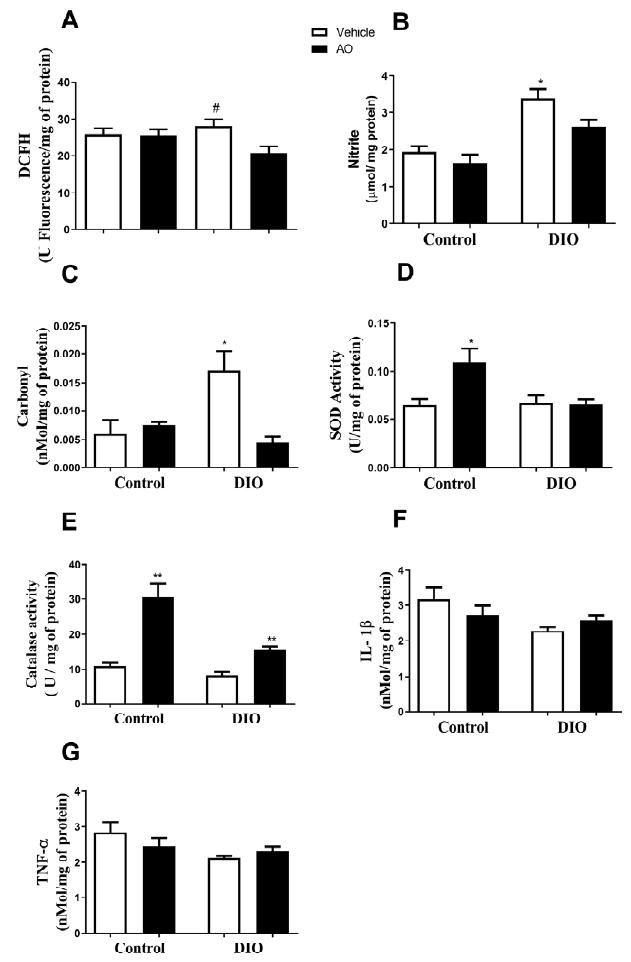
Figure 6. Effects of avocado oil (AO) supplementation on reactive species production, oxidative damage, antioxidant enzymes activity and cytokines levels in the liver of mice with diet-induced obesity (DIO). ( A ) 2 ′ - 7 ′ -Dichlorofluorescin (DCFH) levels ( # DIO > DIO + AO, p < 0.05). ( B ) Nitrite levels (* DIO > control, control + AO and DIO + AO, p < 0.05). ( C ) Carbonyl content of proteins (* DIO > control, control + AO and DIO + AO, p < 0.05). ( D ) Superoxide dismutase (SOD) activity (* control + AO > control, DIO and DIO + AO, p < 0.05). ( E ) Catalase (CAT) activity (** control + AO and DIO + AO > control and DIO, p < 0.05). ( F ) Interleukin 1 β (IL-1 β ) levels. ( G ) Tumor necrosis factor- α (TNF- α ) levels. The results are expressed as the mean ± standard deviation. The data were analyzed statistically using a one-way ANOVA test followed by post hoc analysis using Tukey’s test to compare all pairs of columns. Data were collected from 5 to 7 animals per group. * > control, control + AO and DIO + AO. ** > control and DIO. # > DIO +